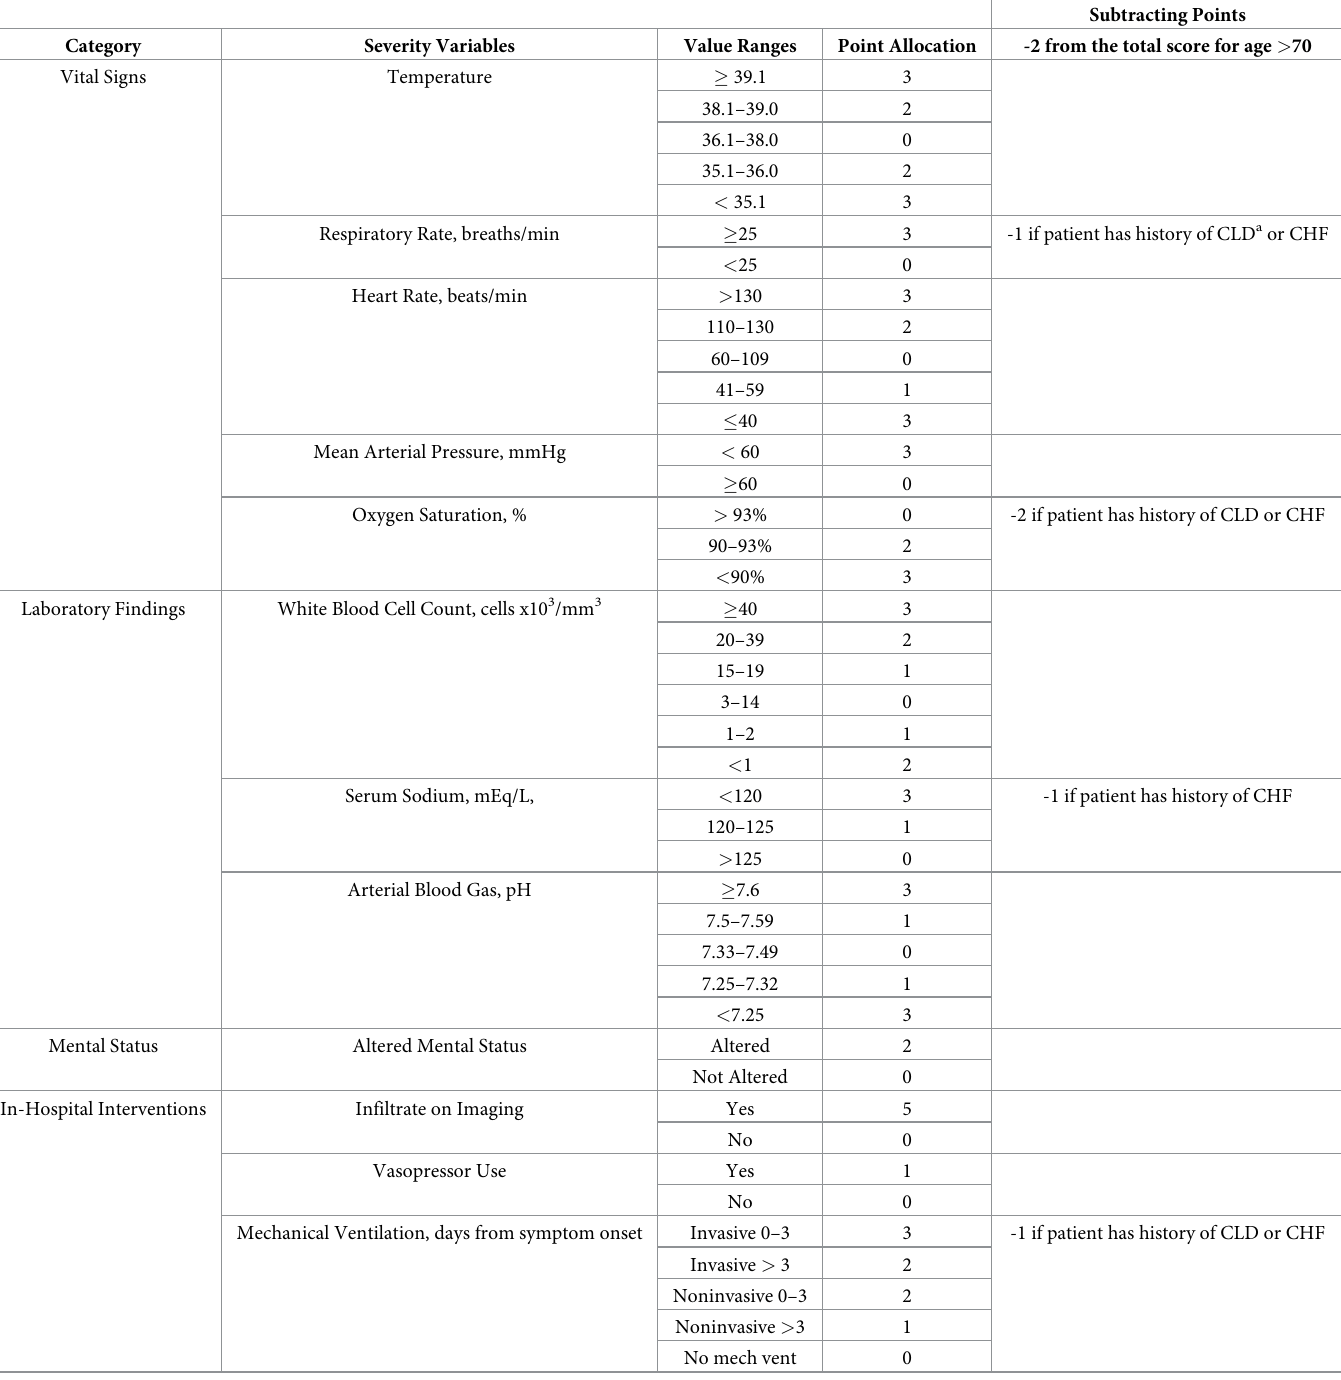
Table 2. Point Allocation based on Physiologic Features and Interventions (PFI) for the Influenza Disease Evaluation and Assessment of Severity (IDEAS)